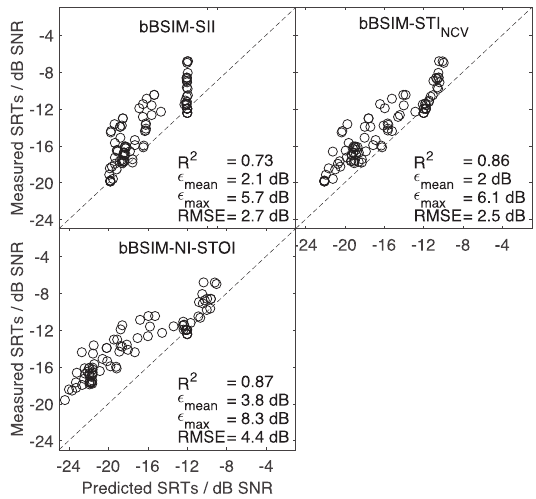
Figure 7. Overall prediction accuracy of bBSIM with three back-ends, with coef fi cient of determination ( R 2 ), mean absolute prediction error ( (cid:1) mean ), maximum absolute prediction error ( (cid:1) max ), and root-mean-square error (RMSE) for all 16